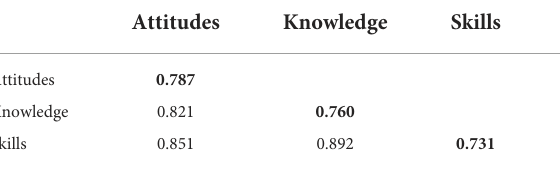
TABLE 3 Fornell larcker criterion showing the discriminant validity among the constructs.